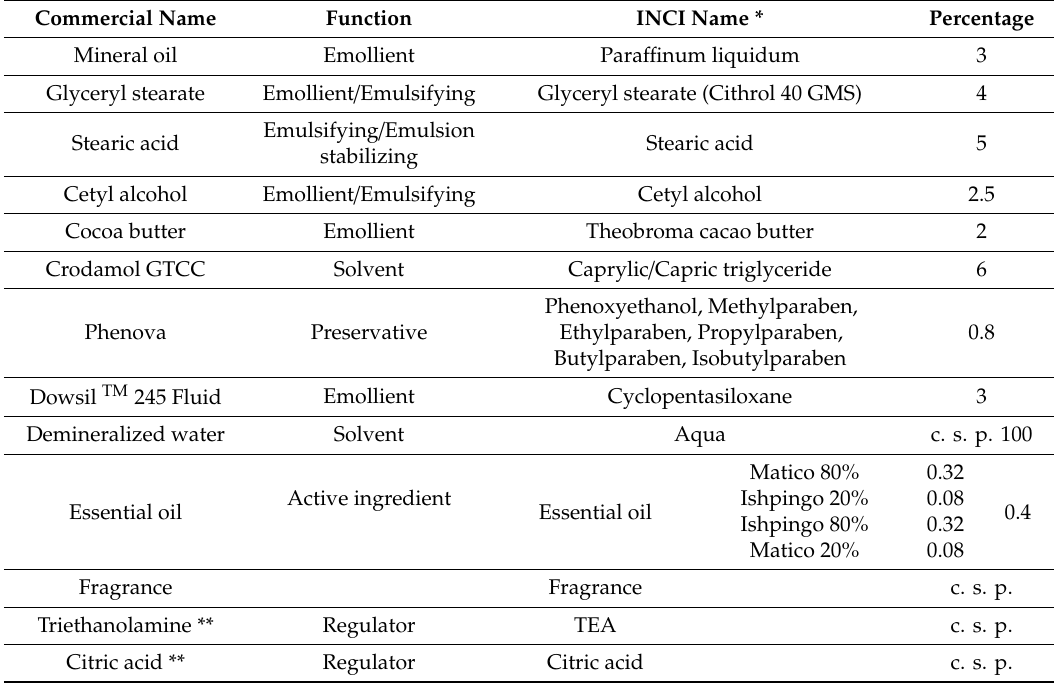
Table 1. Cosmetic formulation of the cream based on Aristeguietia glutinosa ( matico ) and Ocotea quixos ( ishpingo ).